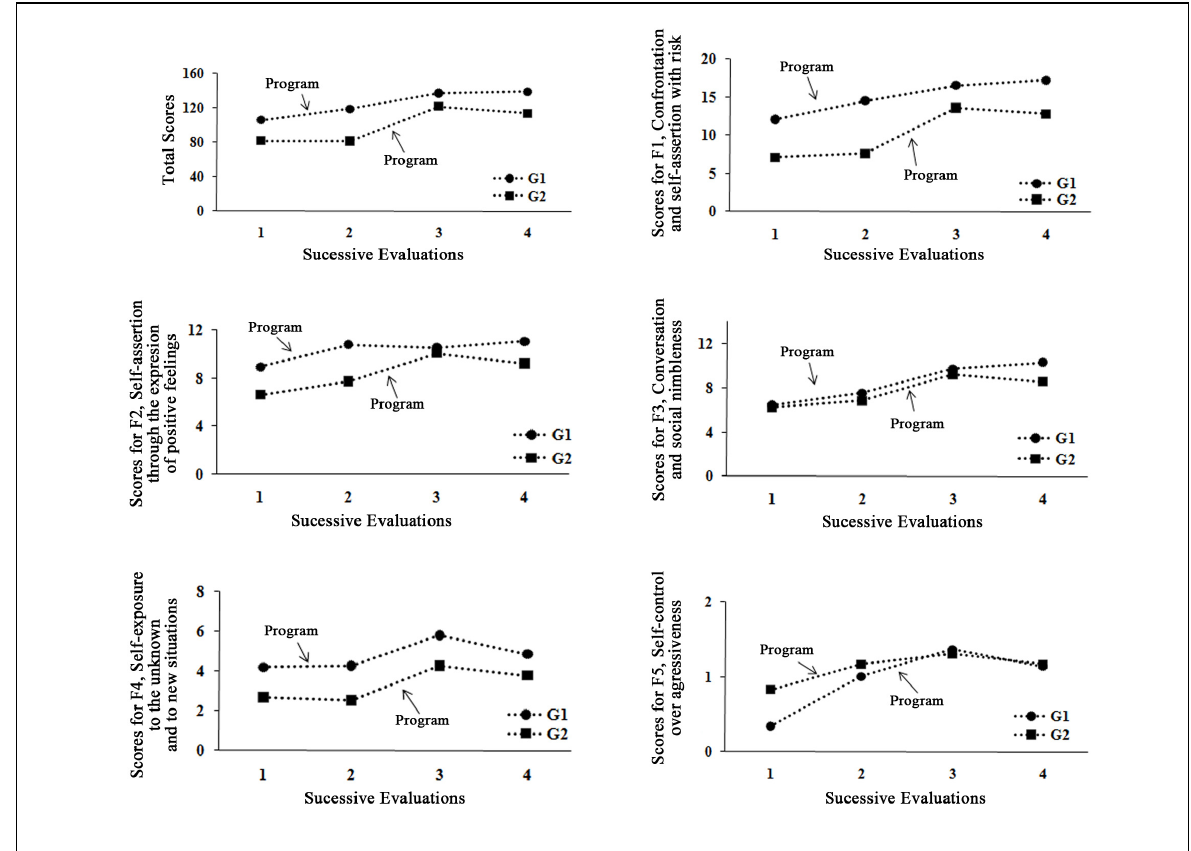
Figure 1 . Median of G1’s and G2’s total score subscales in the SSI-Del-Prette for all four of the evaluations which were conducted. In the Total Score (TS) of the SSI-Del-Prette, the